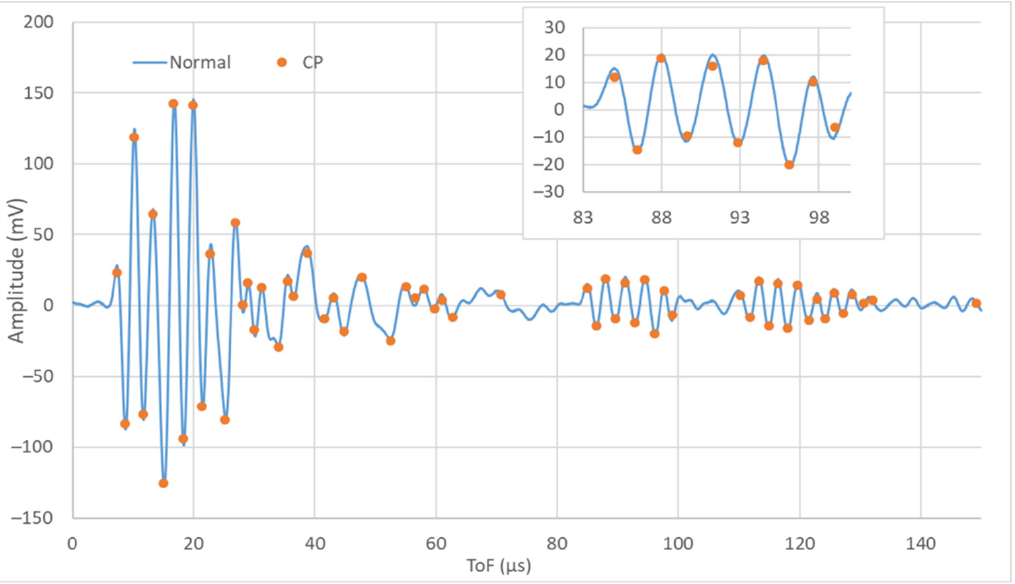
Figure 6. Comparison between a regular acquired signal and a pre-processed signal shown through their CPs (general and detailed views).